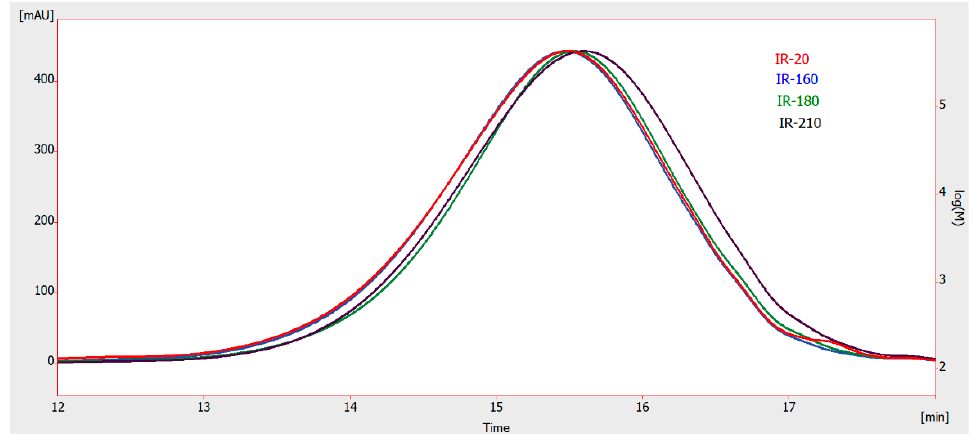
Table 5. Results of macromolecular characteristics of lignins from iroko wood. Data represent mean ± SD.